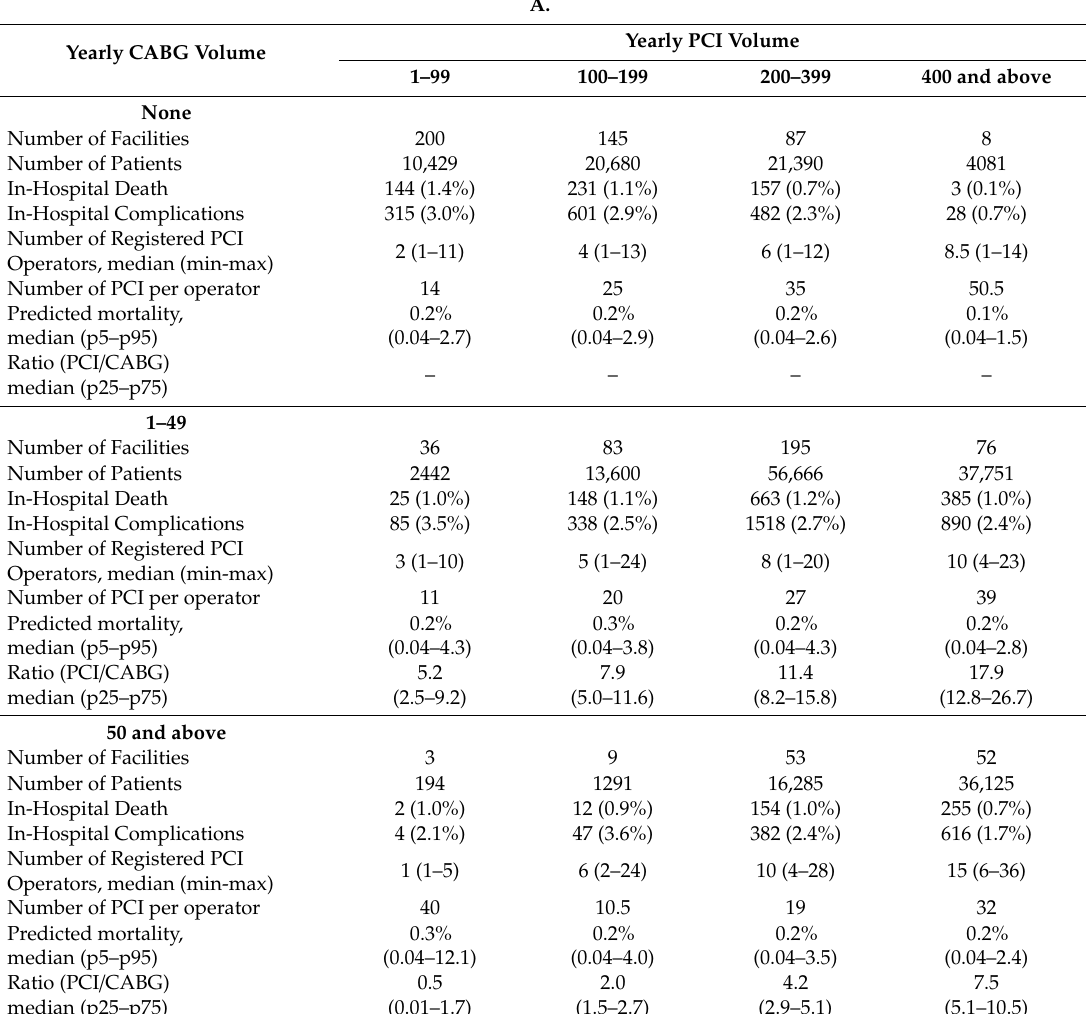
Table 2. Crude ( A ) and adjusted ( B ) in-hospital PCI outcomes by its volume; subcategorized by absolute CABG volume (none, less than 50, and 50 and above /